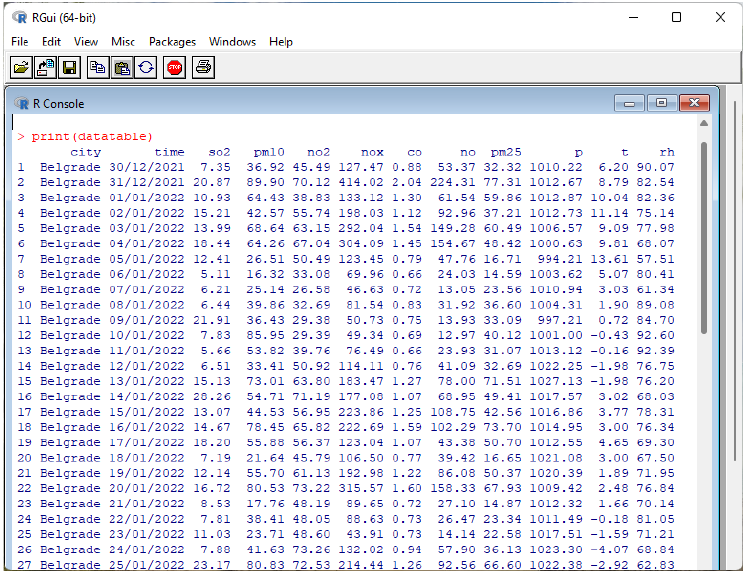
Figure 2. Air pollutants and meteorological measured values loaded into the R GUI.